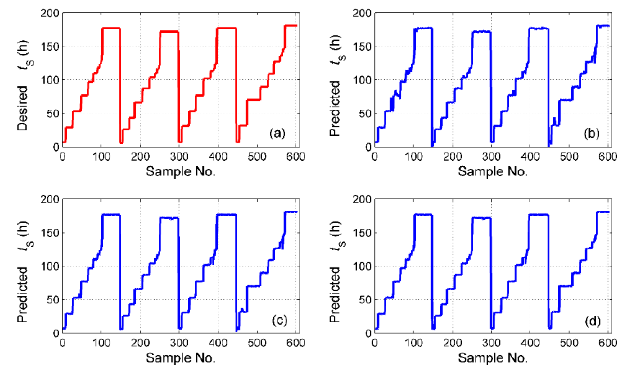
Figure 16. The simulation results of t s for di ff erent fusion schemes, namely: ( a ) desired t s ; ( b ) predicted t s for feature level data fusion; ( c ) predicted t s for decision level data fusion; ( d ) predicted t s for hybrid multi-sensor data fusion.